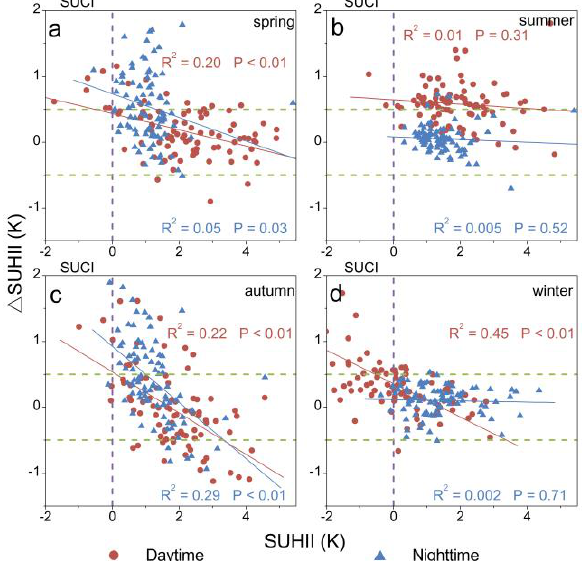
Figure 7. Relationships between the ∆SUHII and SUHII during the four seasons for both daytime and nighttime across the chosen 86 cities in Mainland